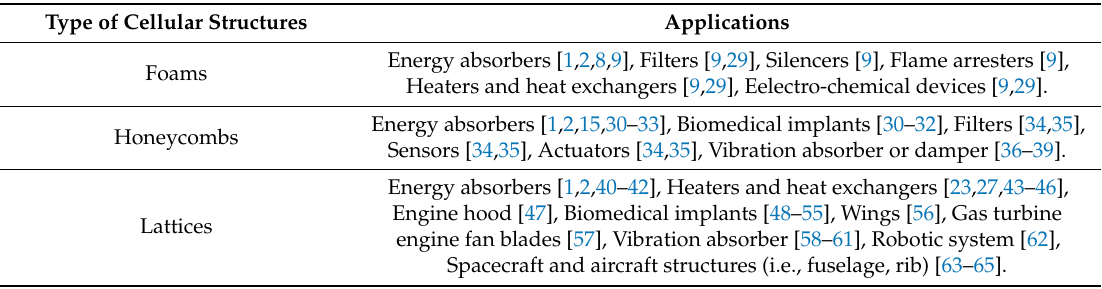
Table 1. Applications of cellular structures.